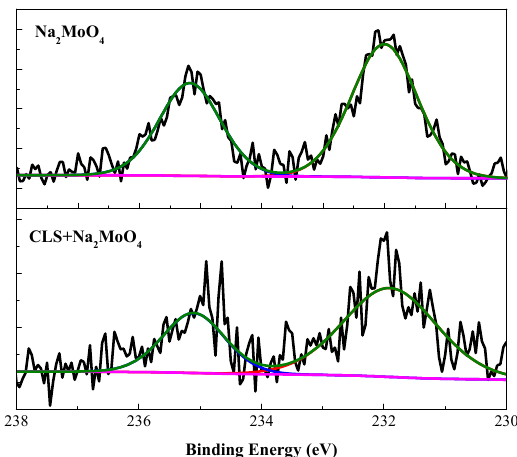
Figure 9. High-resolution XPS spectrum of Mo 3d for Q235 carbon steel immersed in carbonation SCP solution with Na 2 MoO 4 and CLS+Na 2 MoO 4.